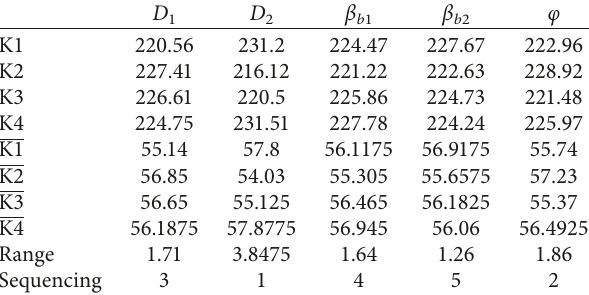
Table 4: Influence data of various factors on